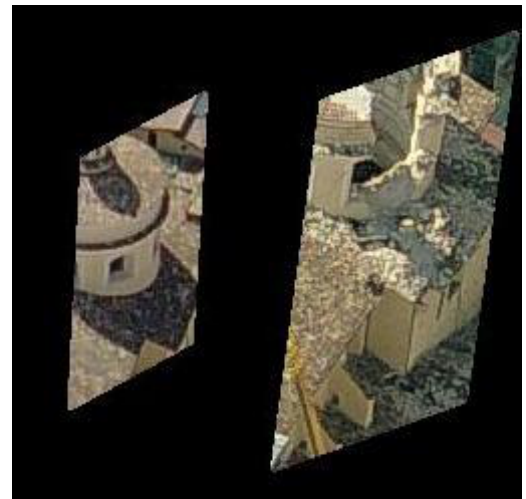
Figure 4. Example of a segmented round roof. In spite of the four façades per building assumption, the façade area is captured.